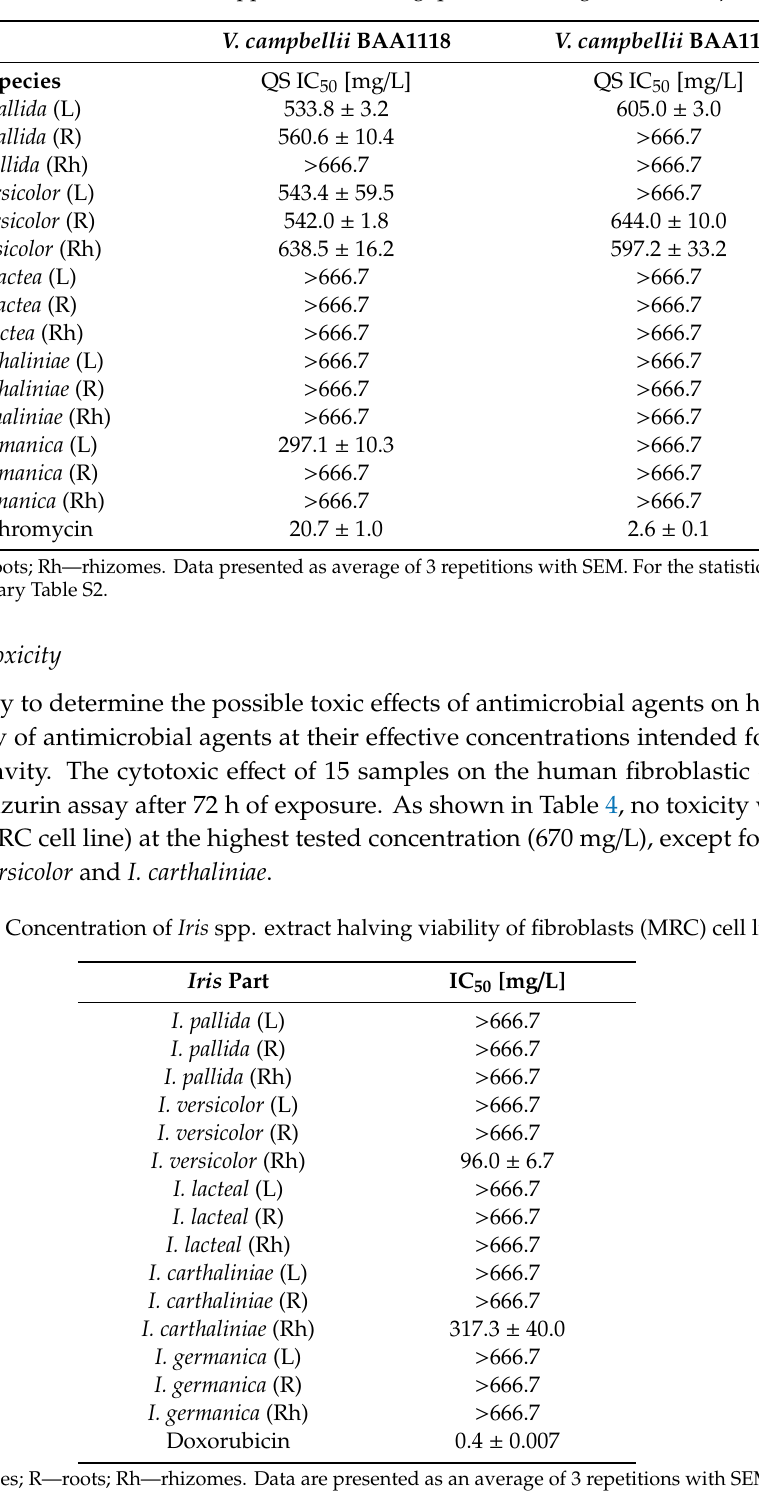
Table 3. Concentration of Iris spp. extract halving quorum sensing of Vibrio campbellii .